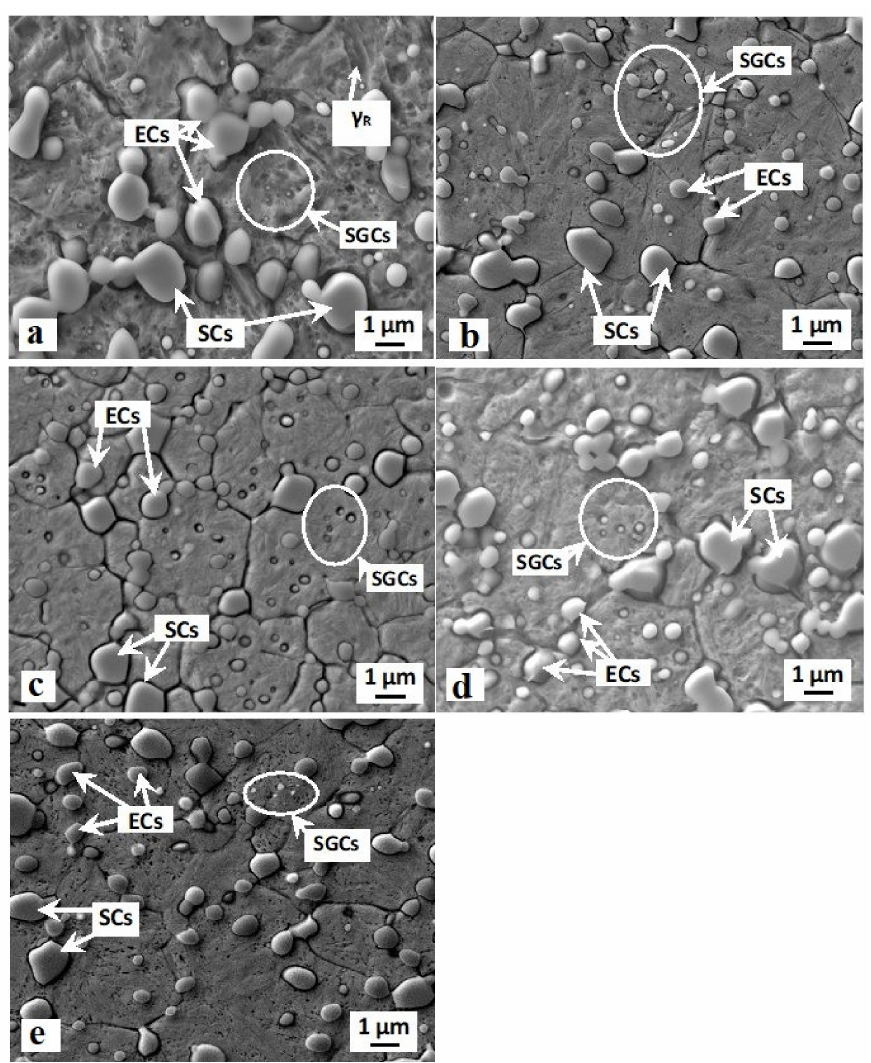
Figure 2. Scanning electron microscopy (SEM) micrographs showing the microstructure of Vanadis 6 ledeburitic steel after conventional room temperature quenching ( a ) and after SZT at − 75 ◦ C ( b ), − 140 ◦ C ( c ), − 196 ◦ C ( d ), and − 269 ◦ C ( e